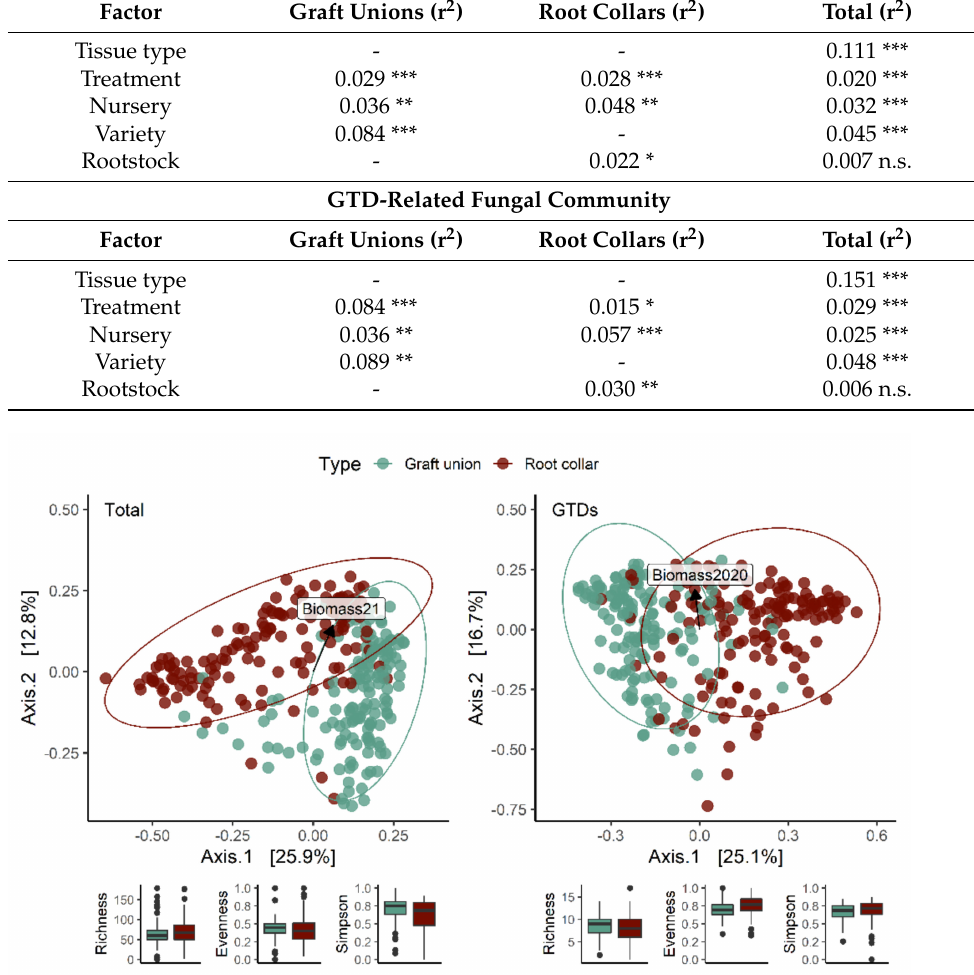
Figure 3. Principal coordinate analysis (PCoA) ordinations calculated with a Bray-distance matrix showing fungal community structures of all communities ( left ) and only GTD communities ( right ) by tissue type. Vectors indicate biomass accumulation for the whole plant in 2020 and 2021. The R 2 and p -values shown are extracted from a PERMANOVA analysis performed with the adonis2 function in R, in which all design variables are included. Alpha diversity indices (species richness, evenness, and Simpson diversity index) are presented below each